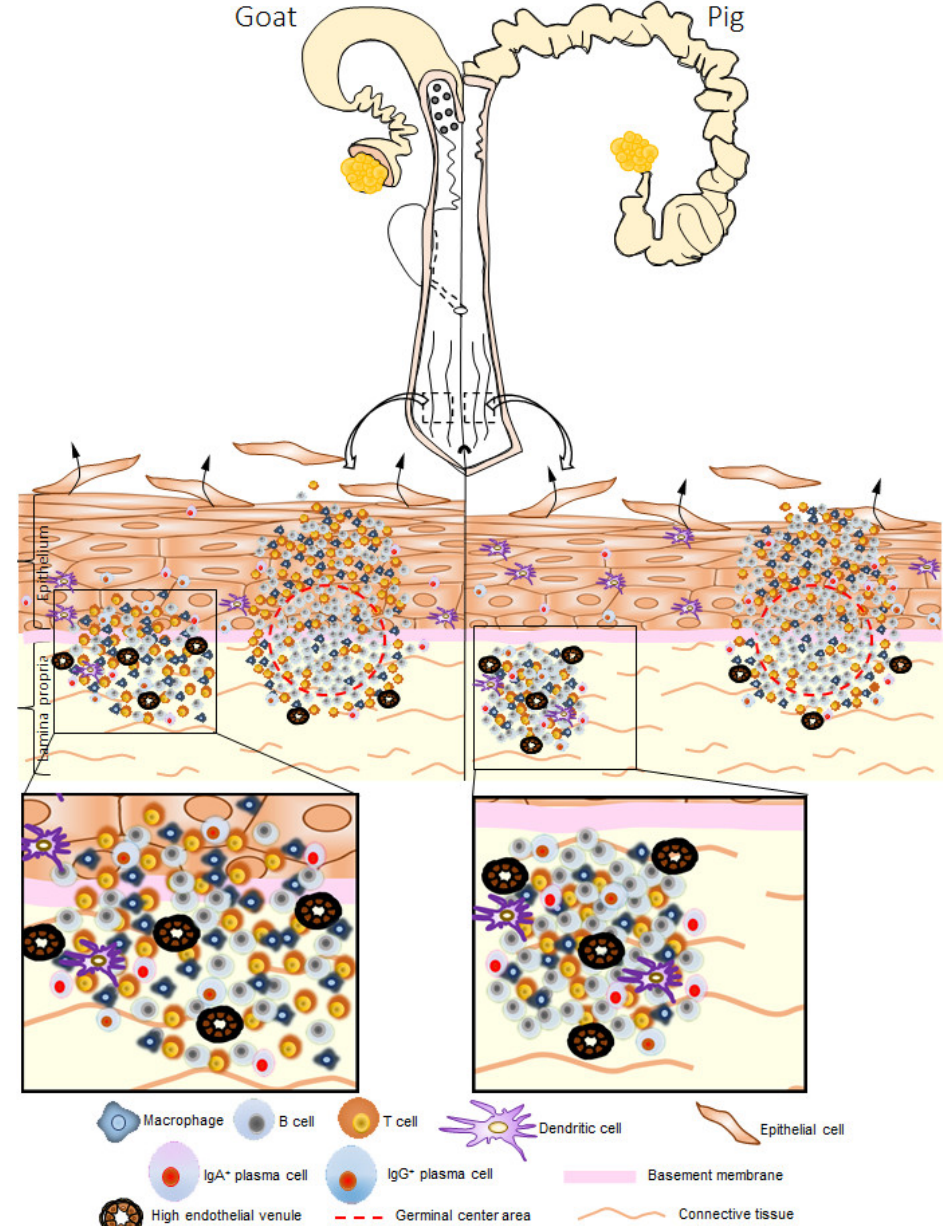
Figure 8. Graphical representation of GOALTs in the VV and reproductive organs of goat and pig. VV is one of the compartments of the EPGO containing GOALTs. GOALTs consist of LNs and DLTs which localize in different parts of LP of the VV. LN and DLT comprised of B cells, T cells, macrophages, and APCs. B cells are predominantly found in both LN and DLT of pigs. Germinal center mainly found in the center of the LN. HEVs observed among LT and neighboring connective tissues in the LP. Basically, the epithelium structure covered GOALTs is partly or thoroughly disrupted by the invasion of immune cells composing LNs and DLTs. LNs and DLTs are arranged as ring in the VV mucosa and titled as “genital lymphoid